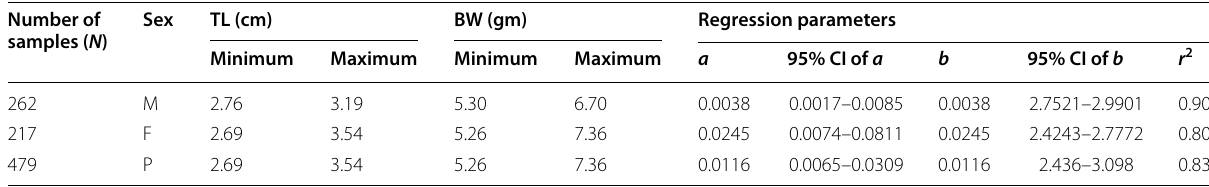
Table 2 Length–weight relationship of Charybdis callianassa species sampled during September 2019–March 2020 from